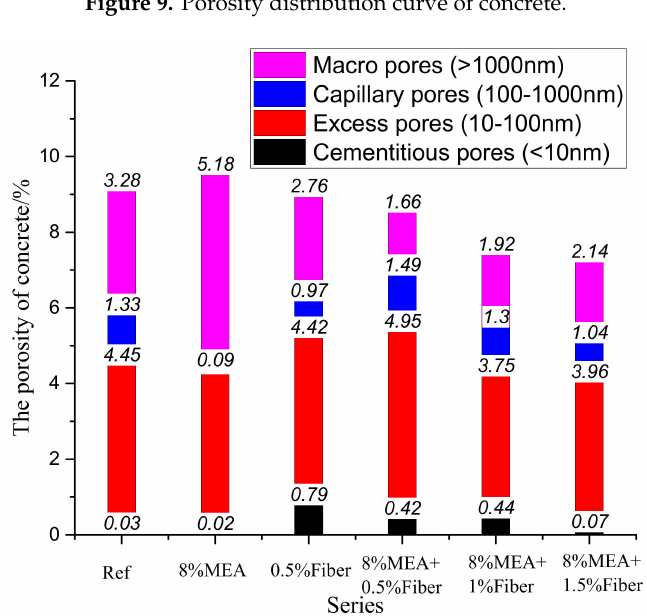
Figure 9. Porosity distribution curve of concrete.